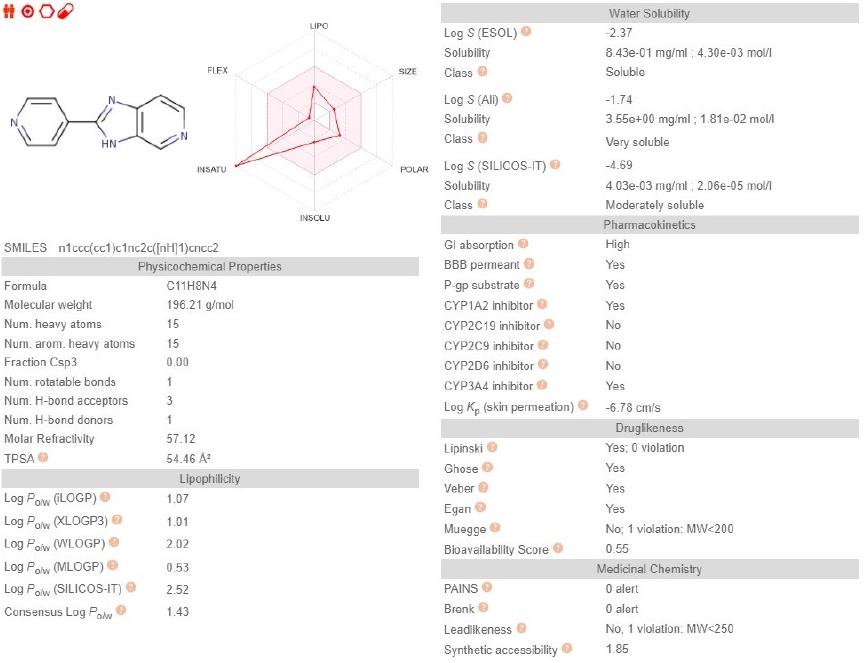
Figure 8. ADME for L1 .